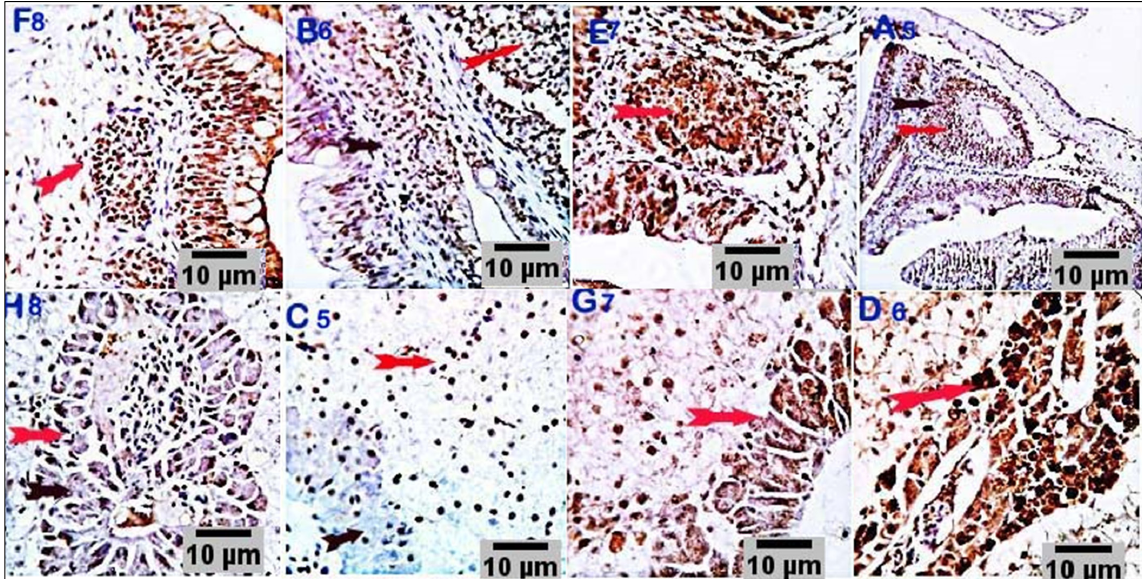
Figure 6. Stained sections of the intestine (F8, B6, E7, and A5) and liver (H8, C5, G7, and D6) of the respective treatment groups (CUR200, CUR400, CUR600, and CUR800) immunostained against caspase-3 showing a moderate number of caspase-positive cells with brownish cytoplasmic reactivity in intestinal cells of different experimental groups (25%, 32%, 35%, and 45% of the cells in CUR200, CUR400, CUR600, and CUR800 groups, respectively). Meanwhile, liver sections (C5, D6, G7, and H8) immunostained with anti-caspase-3 monoclonal antibody showed mild to moderate brownish stainabilities in a variable number of hepatic and hepatic portal pancreatic cells (1.5%, 17%, 18%, and 23% of the cells in CUR200, CUR400, CUR600, and CUR800 groups, respectively). Scale bars = 10 µm.